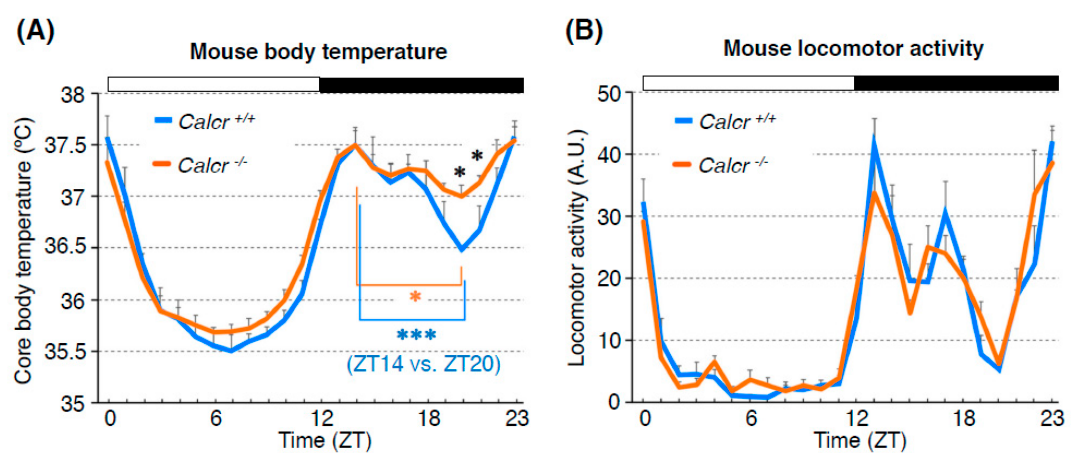
Figure 8. Calcr contributes to body temperature regulation during the night (the active phase for mice). Mouse BTR ( A ) and locomotor activity rhythm ( B ) in control ( Calcr +/+ : blue line) and Calcr knockout ( Calcr − / − : orange line) mice. The body temperatures of wild-type mice showed a deep trough at midnight, whereas the body temperatures of Calcr knockout mice lost the characteristic trough and remained relatively unchanged during the night ( A ). The locomotor activity rhythm in Calcr knockout did not show a significant difference from that of the control, suggesting that Calcr is responsible for mammalian body temperature regulation but not locomotor activity rhythm during the night (the active phase for mice). White and black bars on the graphs indicate the 12-hour light and dark phases. The graphs are modified from Goda et al. 2018, Figure 6 [23]. *: p < 0.05, ***: p < 0.001.